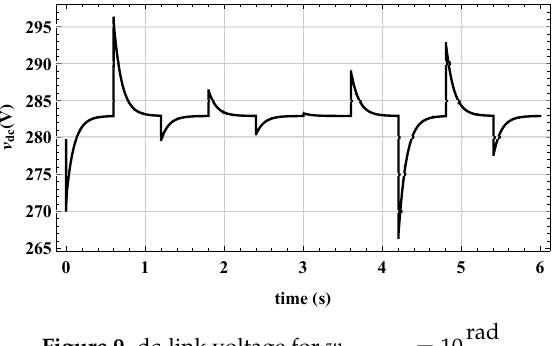
Figure 9. dc-link voltage for w cut − of f =